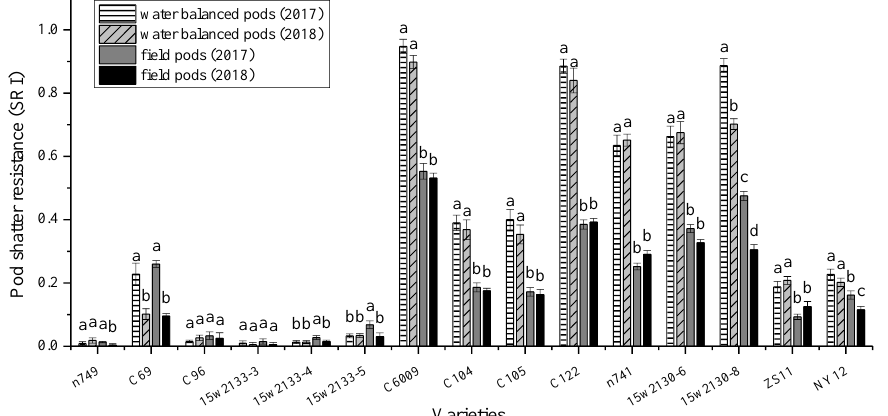
Figure 2. Pod shatter resistance index (SRI) values of the main inflorescence pods of two types (indoor water-balanced pods and field pods) according to the 2-degree-of-freedom collision method in 2016–2018. Lowercase letters indicate that the SRIs differ significantly within one variety based on Fisher’s protected LSD ( p = 0.05).